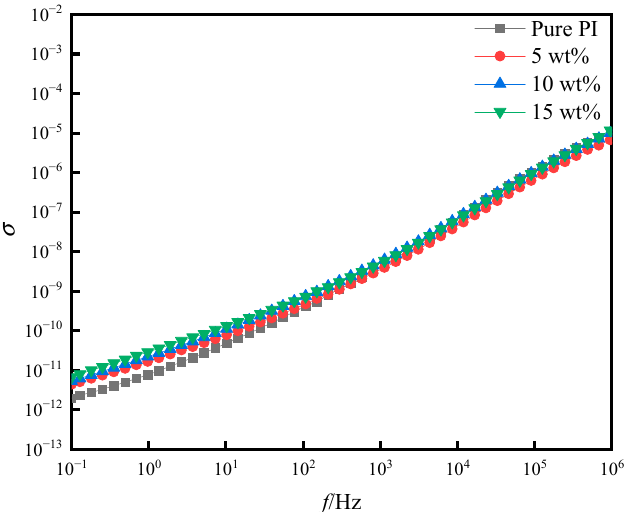
Figure 11. Conductivity of pure PI film and different doping amounts of PI/SiO 2 composite films with frequency.